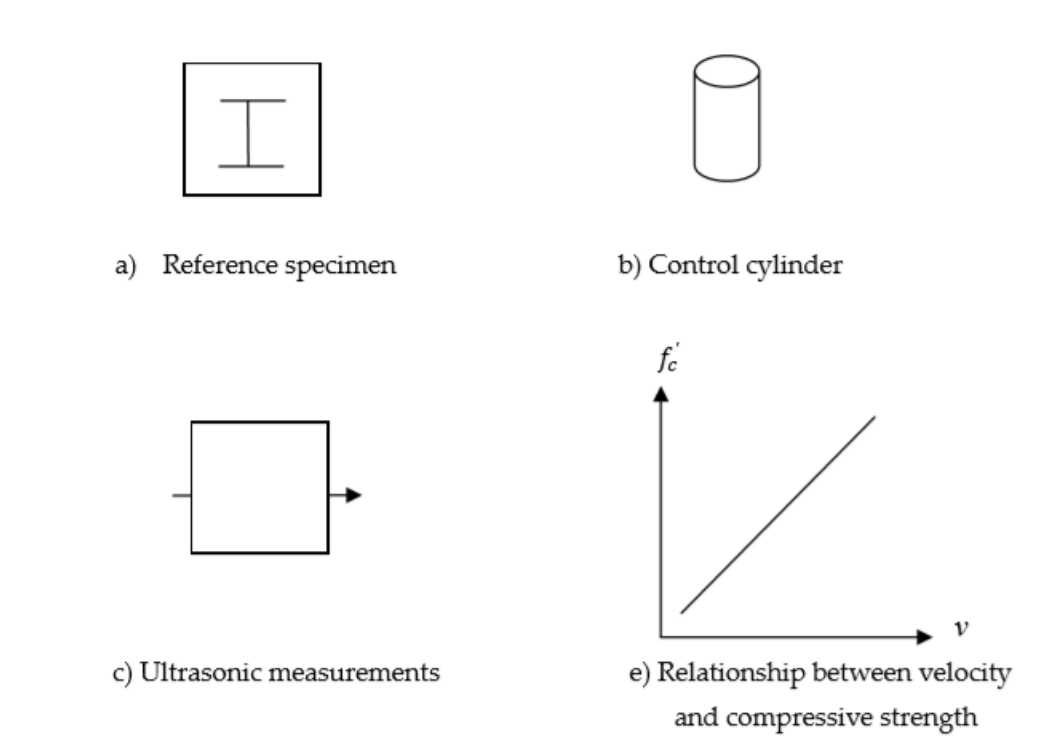
Figure 3. Procedures for field application.